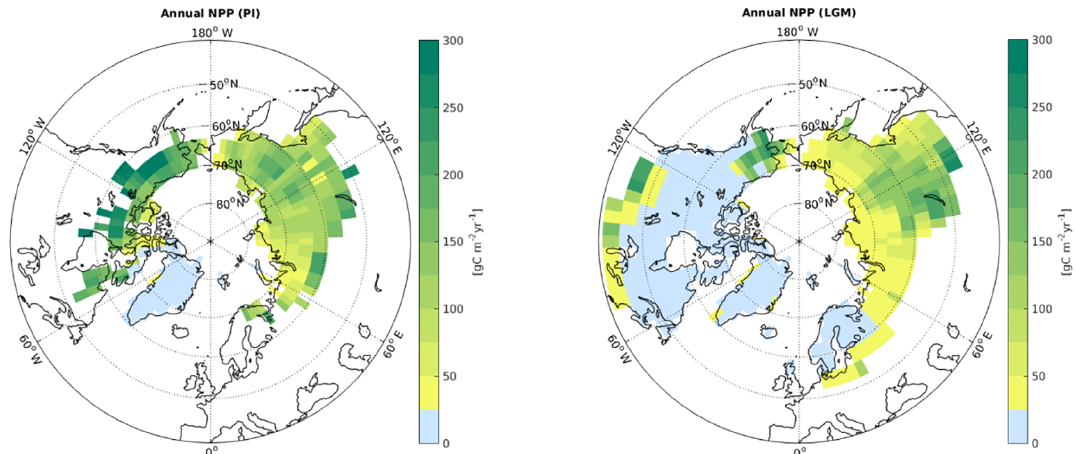
Figure 4. Vegetation productivity (NPP, summed over all vegetation types) in near-surface permafrost regions for PI and LGM simulated by JSBACH. Light bluish-coloured areas show prescribed ice sheet coverage. Data shown represent 100-year time